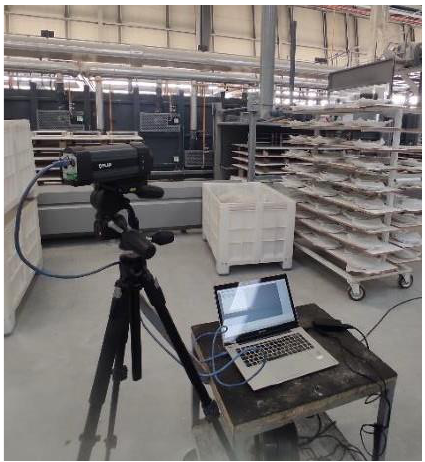
Figure 9. Thermographic camera fixed FLIR A320 Tempscreen.